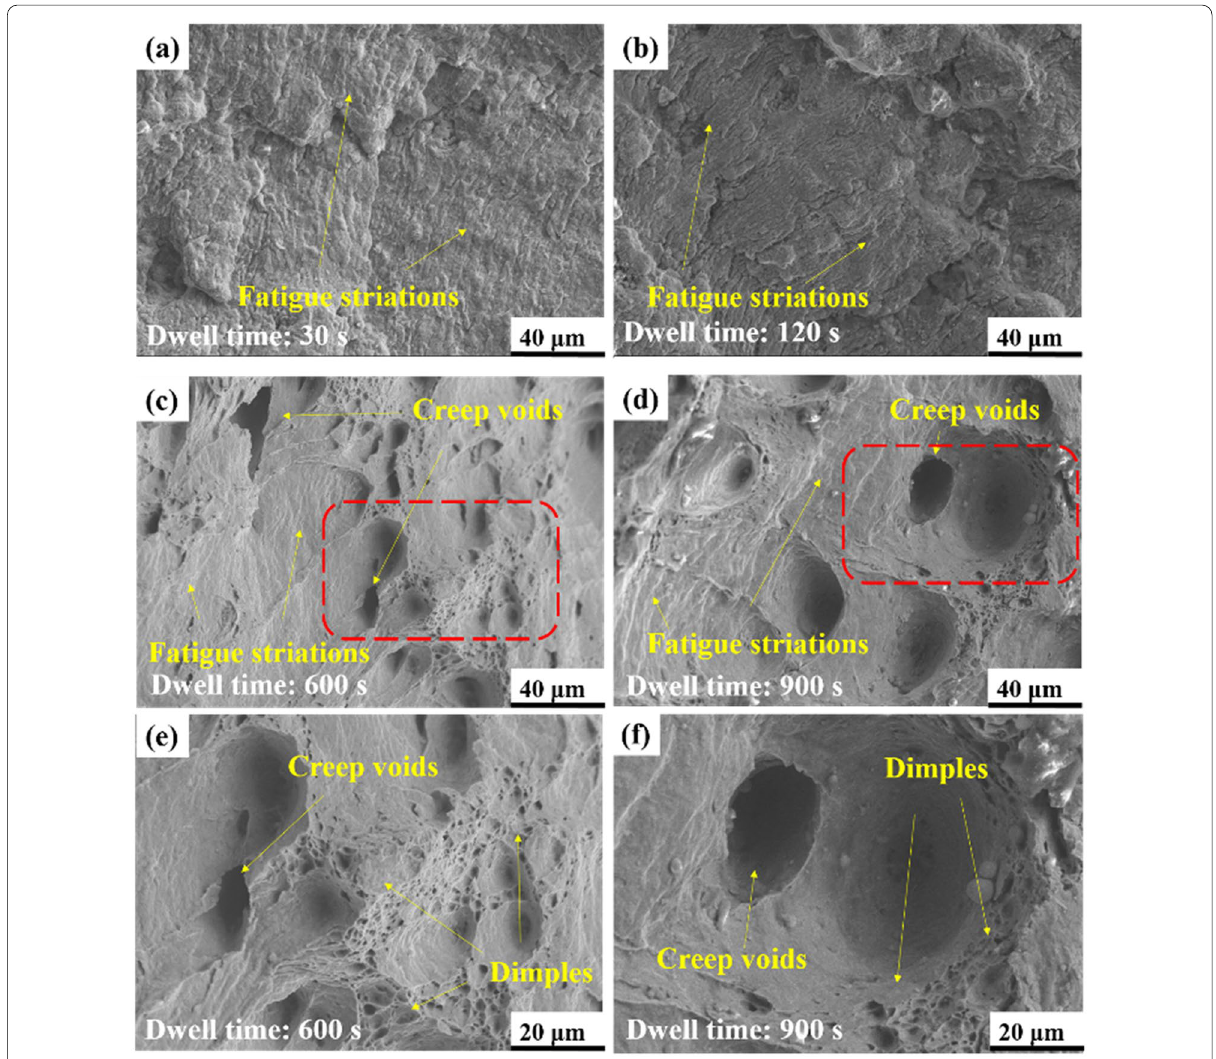
Figure 8 Fracture morphologies of CF specimens with dwell time of ( a ) 30 s; ( b ) 120 s; ( c ) 600 s and ( d ) 900 s; ( e ) and ( f ): the fracture morphologies of the areas, which were surrounded by red dash lines in ( c , d ) at high